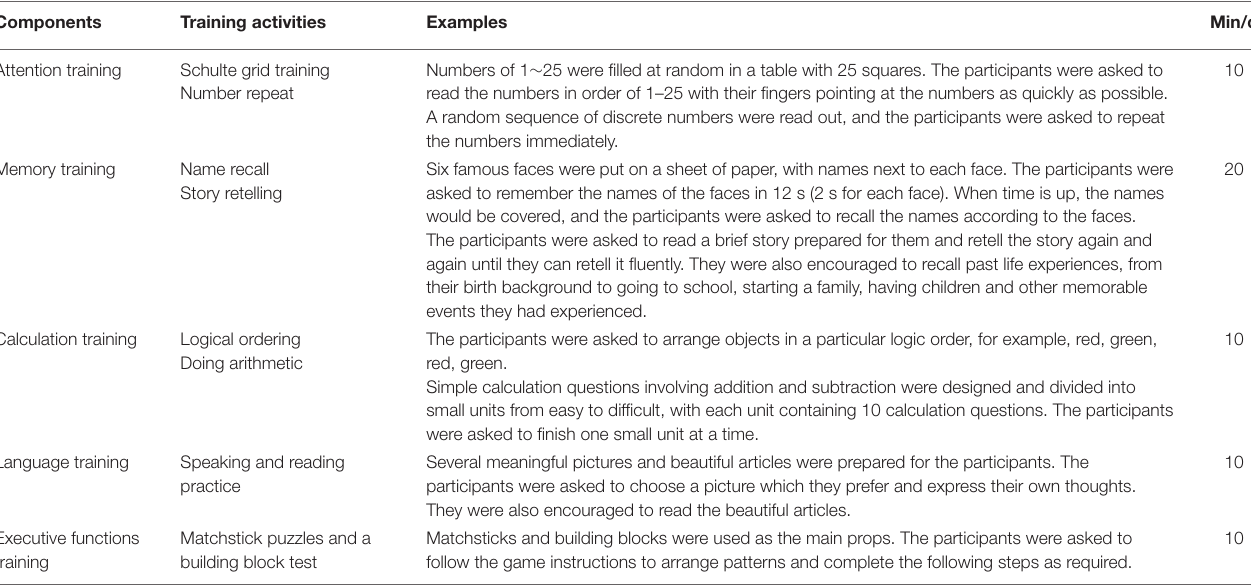
TABLE 1 | Components of cognitive